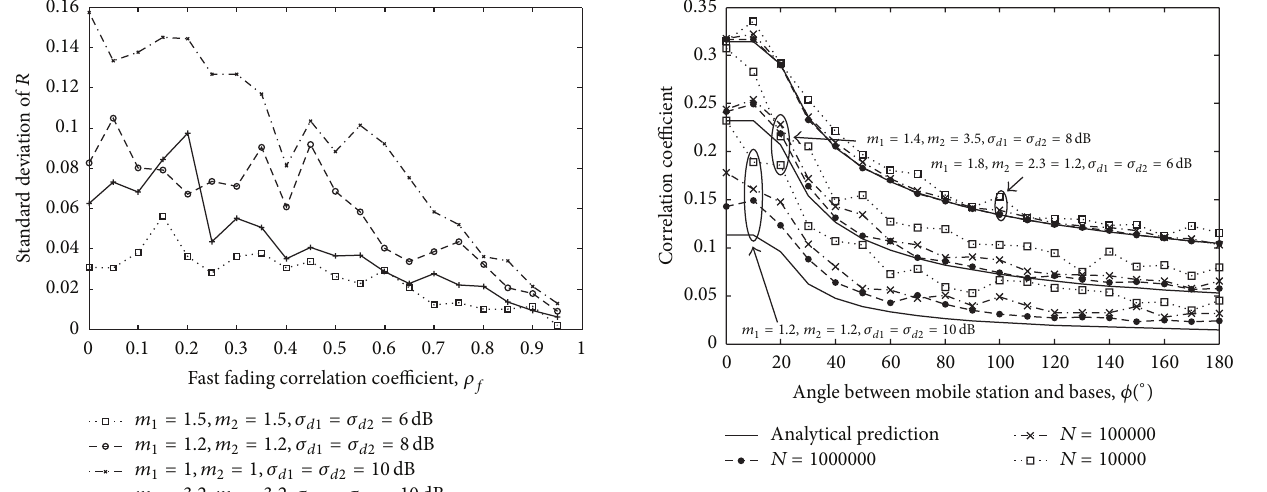
m 1 = 1.4,m 2 = 3.5,𝜎 d1 = 𝜎 d2 = 8 dB m